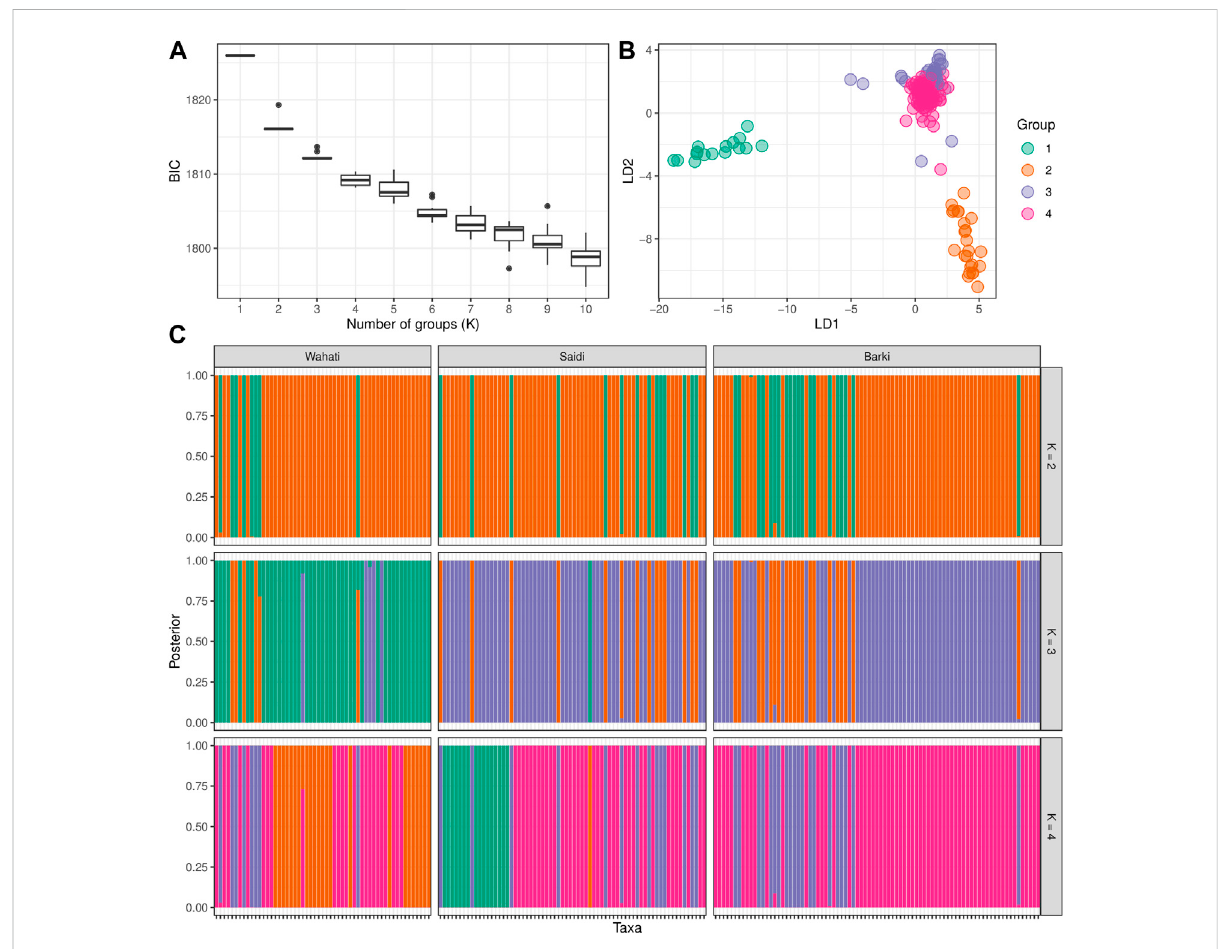
FIGURE 4 Population structure determined by the discriminant analysis of principal components (DAPC) algorithm. (A) The optimal number of clusters (k-means) solutions compared using the Bayesian Information Criterion (BIC). (B) The linear discriminant analysis (LDA) produced using dimension- reduction depending on DPAC algorithm. (C) The STRUCTURE-like plot of the studied population based on the best K